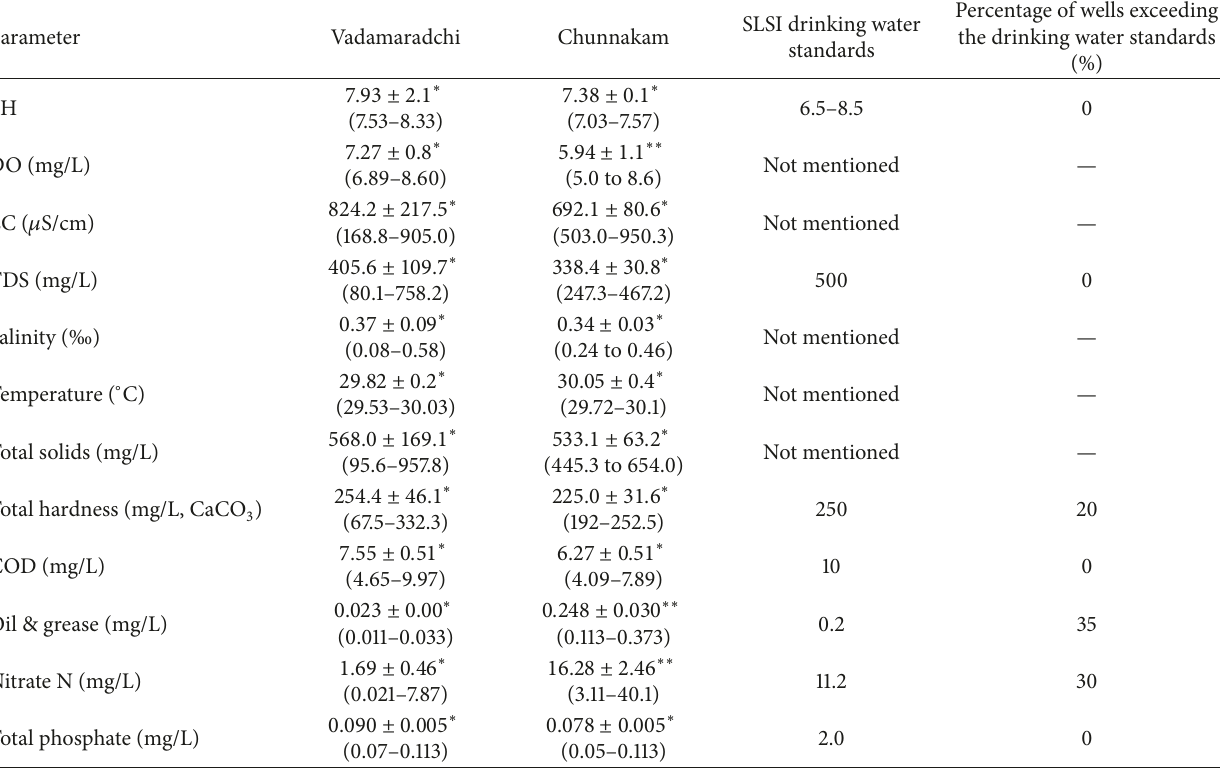
Table 1: Mean ± SD of water quality parameters of the domestic wells in Vadamaradchi and Chunnakam areas during the study period, drinking water standards established by the Sri Lanka Standards Institution (SLSI 614, 2013 [18, 19]), and the percentage of sampled wells exceeding SLSI drinking water standards. In Vadamaradchi and Chunnakam columns, different superscripts ( ∗ and ∗∗ ) at each row (for each water quality parameter) indicate significant differences from each other at 95% level of significance ( p < 0.05, Student’s t -test, n = 10). The range of water quality parameters of the domestic wells in Vadamaradchi and Chunnakam areas is given within